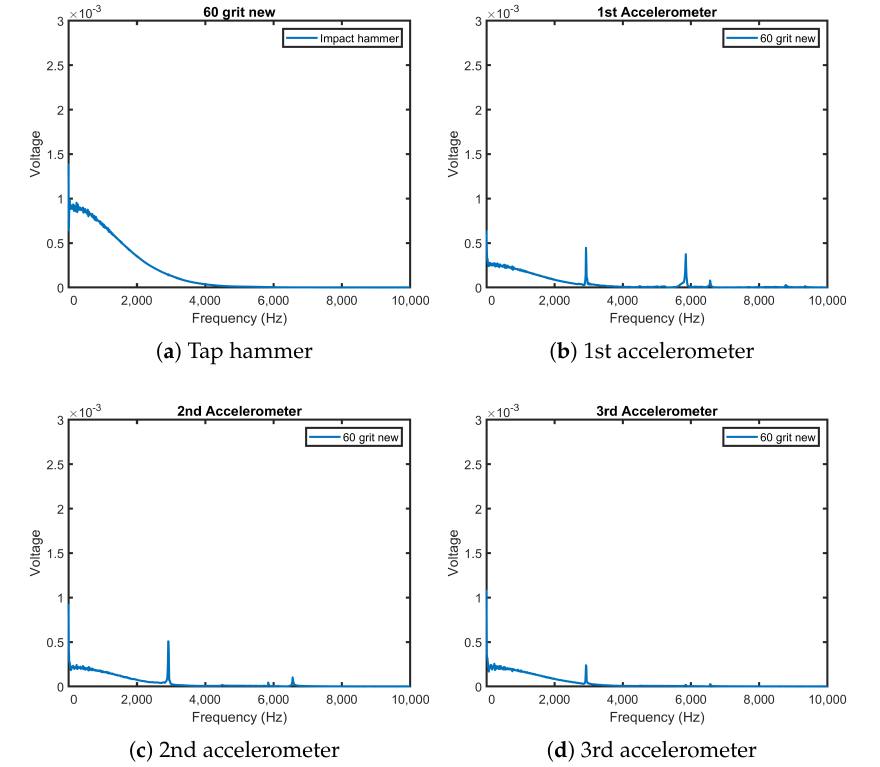
Figure 13. Typical natural frequency result of the new 60 grit